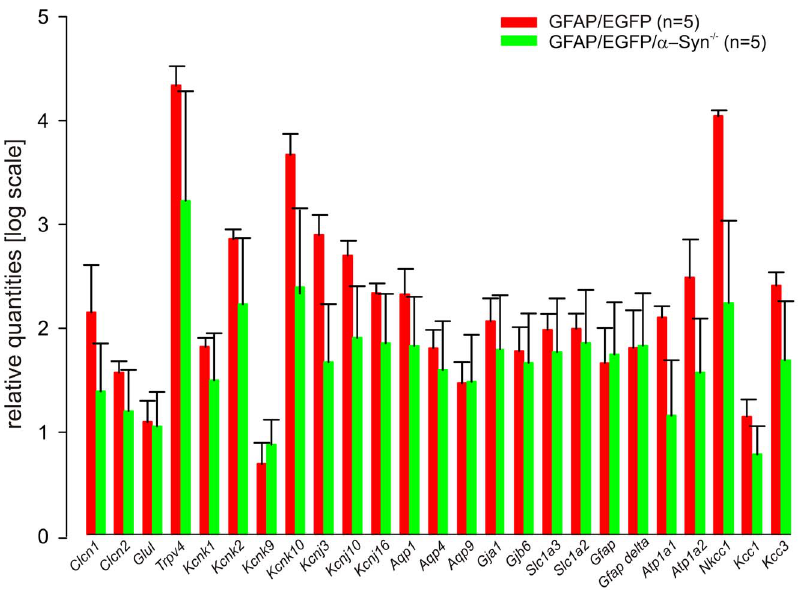
Figure 9. Gene expression profile of cortical astrocytes from GFAP/EGFP and GFAP/EGFP/ a -Syn 2 / 2 mice. Bar graph indicating the mRNA expression levels for all analyzed genes in 198,400 astrocytes isolated from 5 GFAP/EGFP (red) and 206,640 astrocytes from 5 GFAP/EGFP/ a -Syn 2 / 2 mice (green); the mRNA levels are presented as the mean ¡ SEM. Clcn1 and Clcn2 code the voltage-gated chloride channels ClC1 and ClC2; Glul encodes glutamine synthetase; Trpv4 encodes the transient receptor potential vanilloid 4 channel TRPV4; Kcnk1 , Kcnk2 , Kcnk9 and Kcnk10 code the two pore domain K + channels TWIK-1, TREK-1, TASK-3 and TREK2; Kcnj3 , Kcnj10 and Kcnj16 code the inwardly rectifying K + channels Kir3.1, Kir4.1 and Kir5.1; Aqp1 , Aqp4 and Aqp9 code the water channels AQP1, AQP4 and AQP9; Gja1 and Gjb6 code connexin43 and connexin30; Slc1a3 and Slc1a2 code the glutamate transporters GLAST and GLT-1, Gfap and Gfap-delta code glial fibrillary acidic protein and its d splice variant. Atp1a1 and Atp1a2 code Na + /K + - ATPases alpha 1 and 2, Nkcc1 , Kcc1 and Kcc3 code Na-dependent or independent K + /Cl 2 co-transporters.